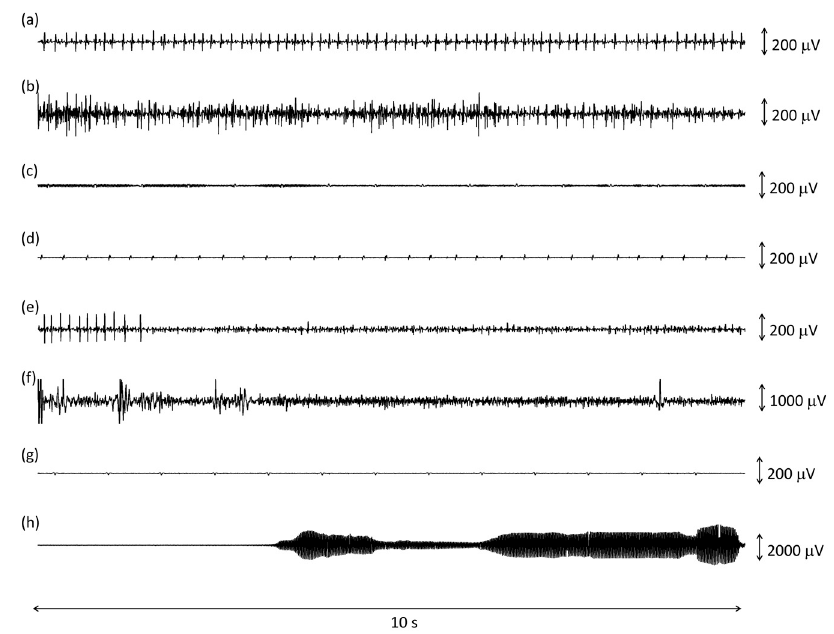
Figure 1. Examples of 10 s epochs analyzed by the algorithm classified as true positive ( a , b ), false positive ( c , d ), false negative ( e , f ), and true negative ( g , h ) when compared to the golden standard. See text for further details.